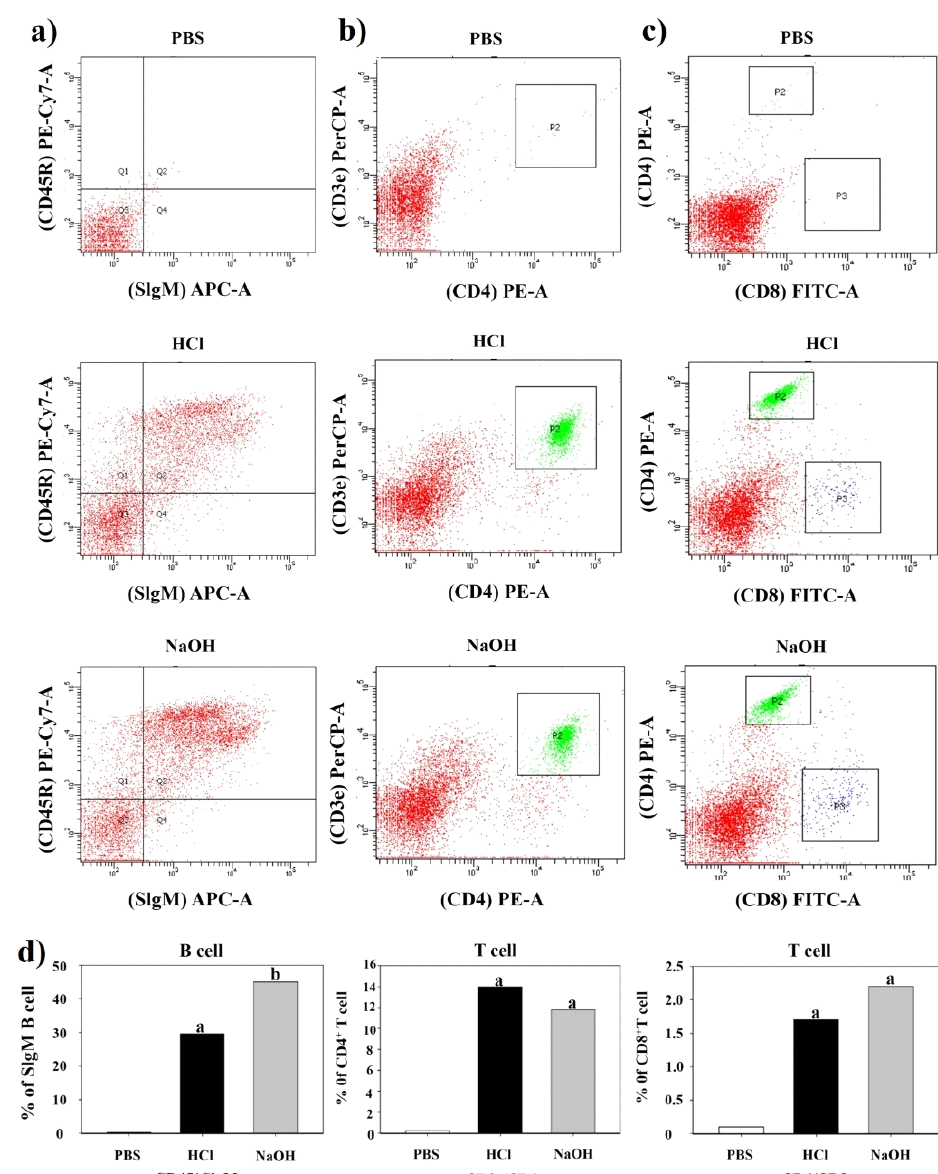
Figure 7. Assessment of B cells, CD4 + and CD8 + T-cells by FACS analysis. Populations of B cells, CD4 + , and CD8 + T-cells from PBS-injected control, HCl-induced LMGs immunized, and NaOH-induced LMGs immunized groups one week (week 6) after the final immunization. Red color areas represent reaction intensities between CD45R marker and SIgM (a column), between CD3e marker and CD4 (b column), and between CD4e marker and CD8 (c column). P2 box indicates a strong reaction between CD3 marker and CD4 (b column). P2 box and P3 box indicate CD4 reaction and CD 8 reaction, respectively ( c ) column. ( d ) row Percent (%) population of B cells, CD4 + T cells, and CD8 + T cells corresponding ( a – c ) analyses.